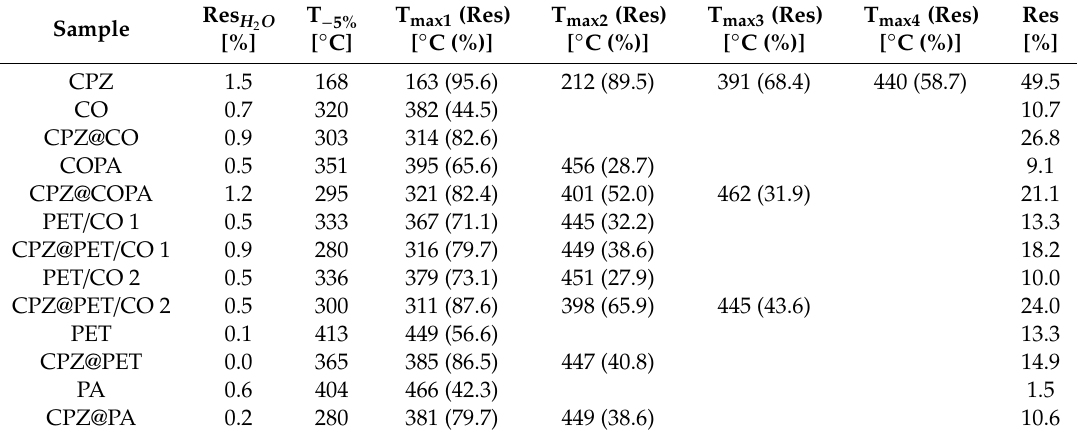
Table 2. Overview of the Thermogravimetric analysis (TGA) parameters measured under nitrogen with 20 K / min heating rate. T max is obtained by the derived TGA curve. The add-on was for all samples around 10